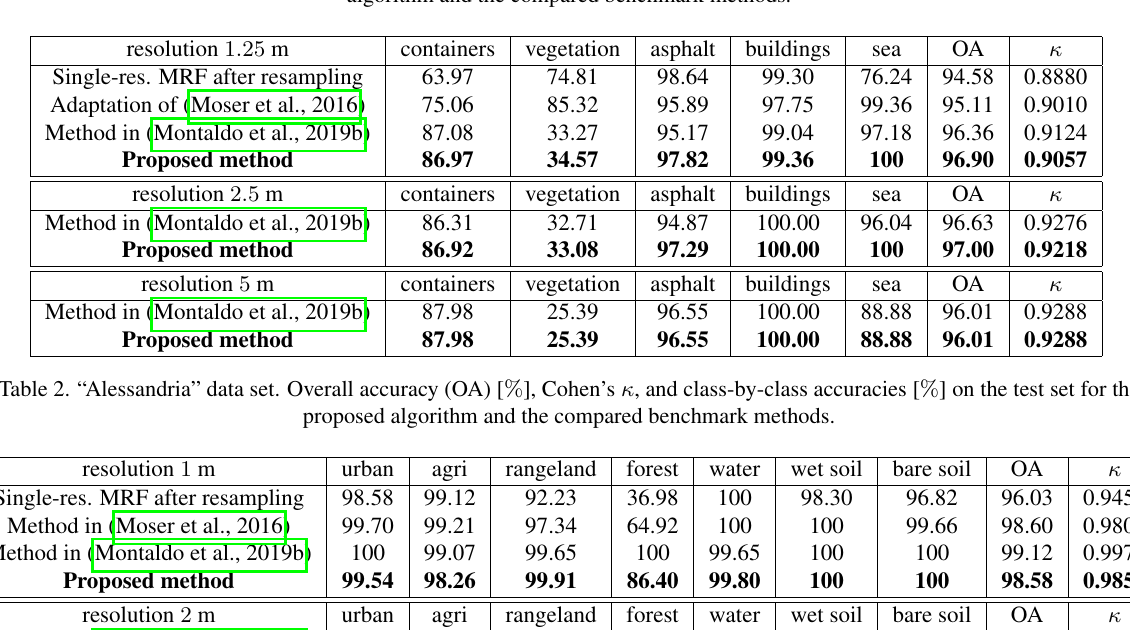
Table 1. “Haiti” data set. Overall accuracy (OA) [ % ], Cohen’s κ , and class-by-class accuracies [ % ] on the test set for the proposed algorithm and the compared benchmark methods.